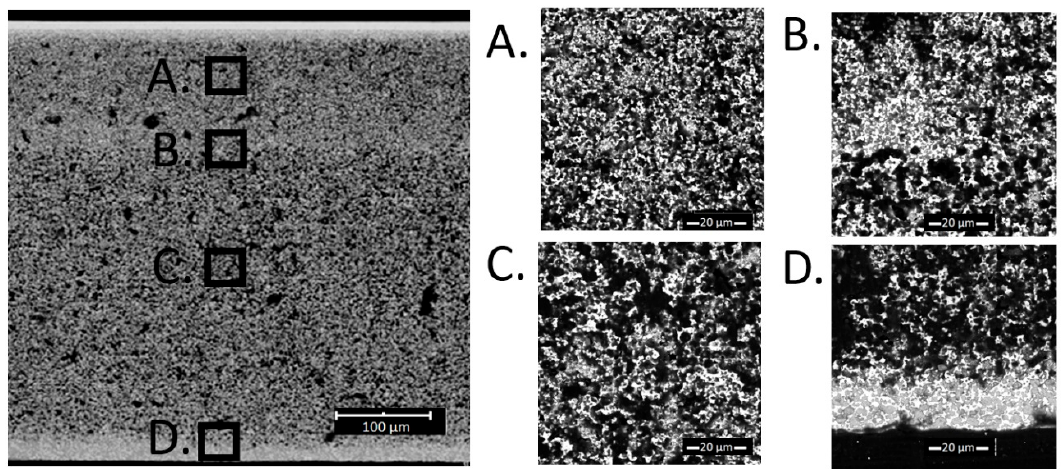
Figure 6. SEM cross-section images of a sample with 30 vol.% NiO obtained using the “fast” method. ( A ) is the region of the functional layer, ( B ) is the interface between the functional and the porous layer, ( C ) is the porous functional layer and ( D ) is close to the outer edge of the cell.